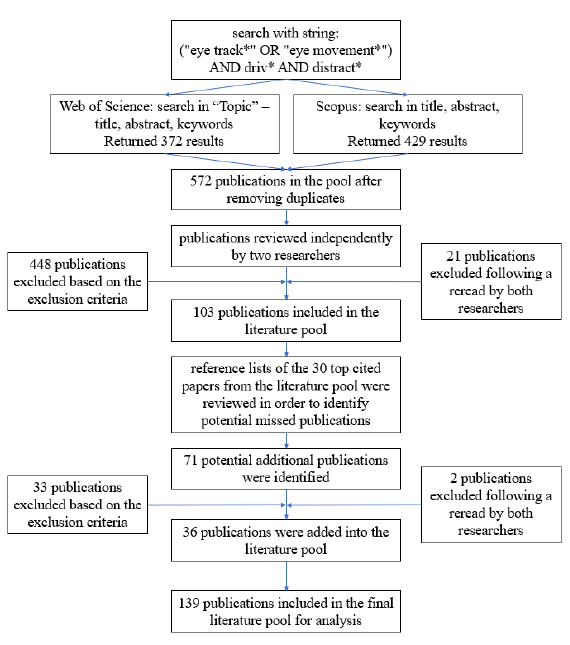
Figure 1. Publication selection process.